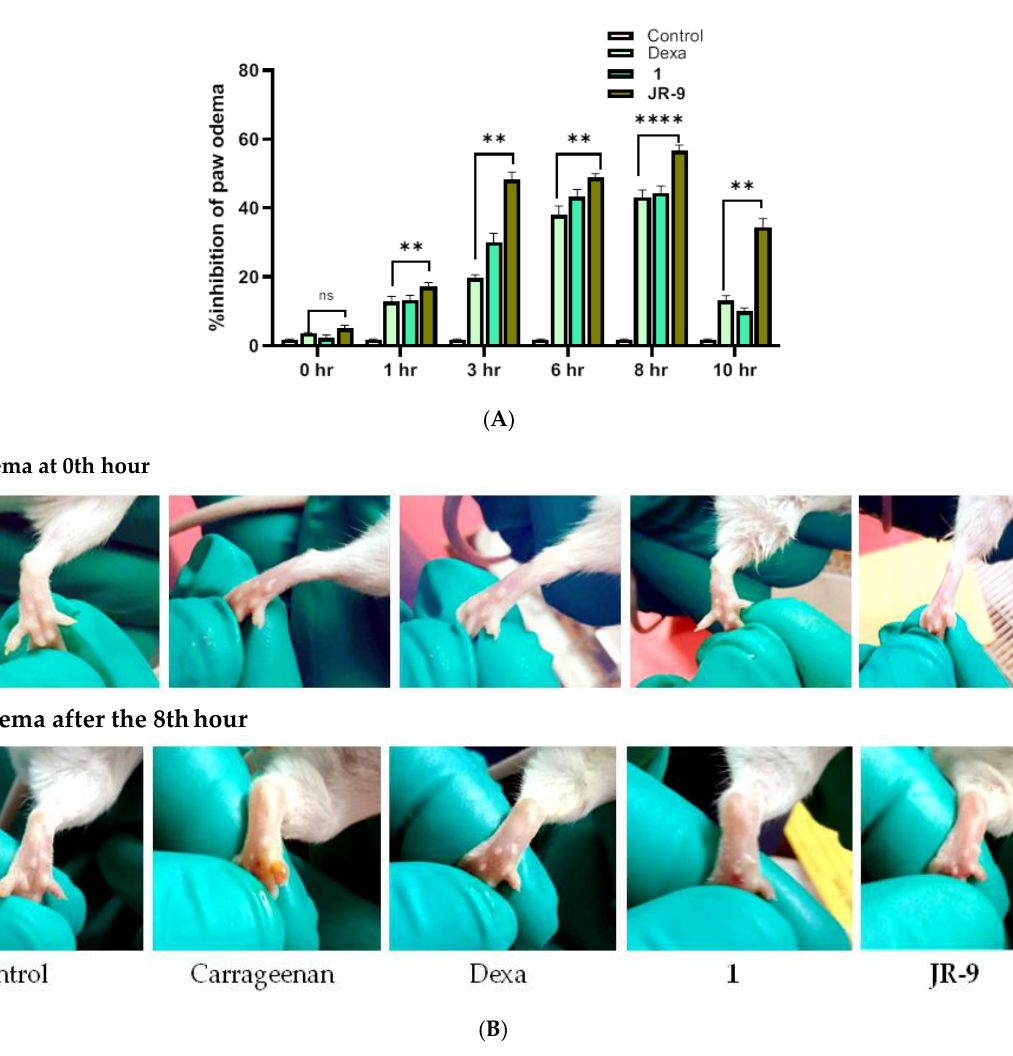
Figure 8. ( A ) Graphs showing an increase in the inhibitory effect of JR-9 compared to 1 and Dexa (20 mg/kg); the maximum effect was noticed at the 8th hour of the subcutaneous injection of carrageenan. Each value represents mean ± SD, n = 5 (**** p < 0.0001, ** p < 0.05 indicated significant difference as compared to the control group assessed by two-way ANOVA followed by Tukey test). ( B ) Comparative effect of 1 and JR-9 at 40 mg/kg dose on carrageenan-induced paw edema: Compounds or vehicle was administrated 1 h prior to carrageenan injection (1%), and paw volume measured.